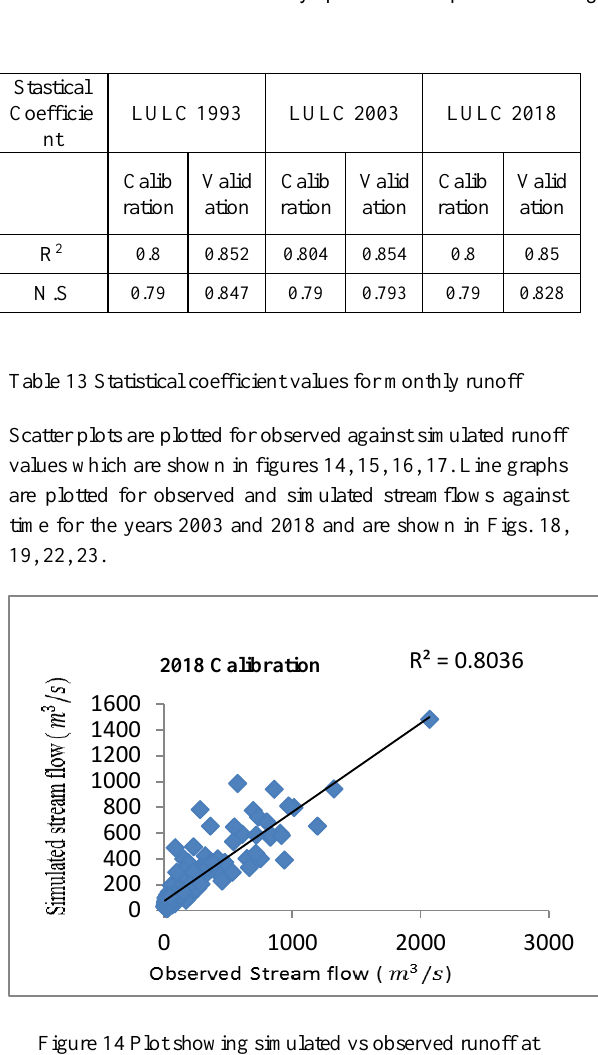
Figure 14 Plot showing simulated vs observed runoff at monthly time step for the year 2018(Calibration)